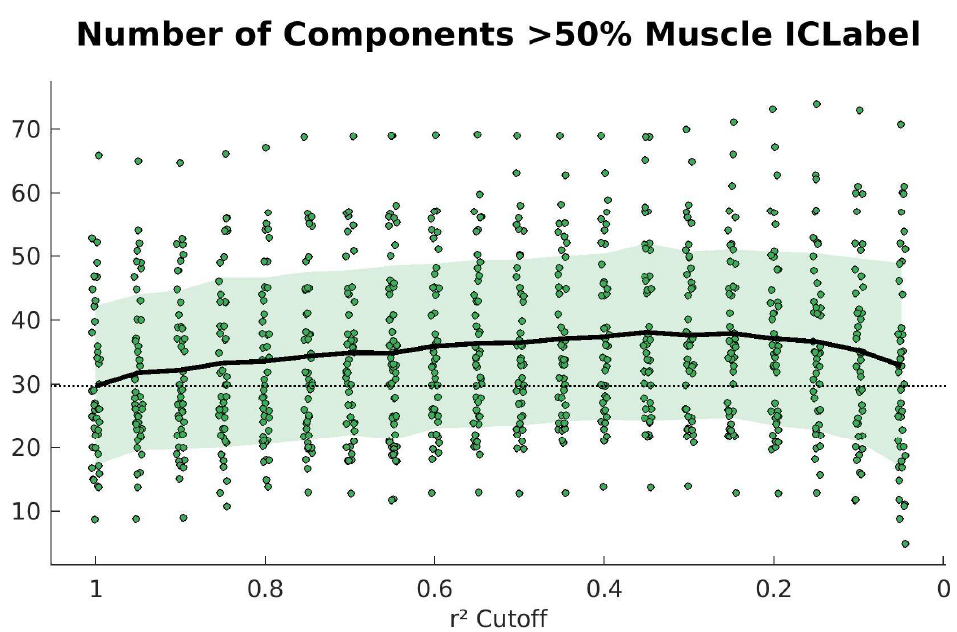
Figure 6. Number of muscle components labeled by ICLabel after using iCanClean to remove motion artifact (4 s window, range of cleaning intensities tested via r 2 cutoffs). The average is shown as a bold black trace over the data points and the standard deviation is shaded in green. The average when iCanClean is not used is shown as a dotted black line. The number of muscle components increases at the ideal iCanClean parameter (r 2 of 0.65). This increase is reasonable because the removal of motion artifacts should reveal both more brain and muscle components.